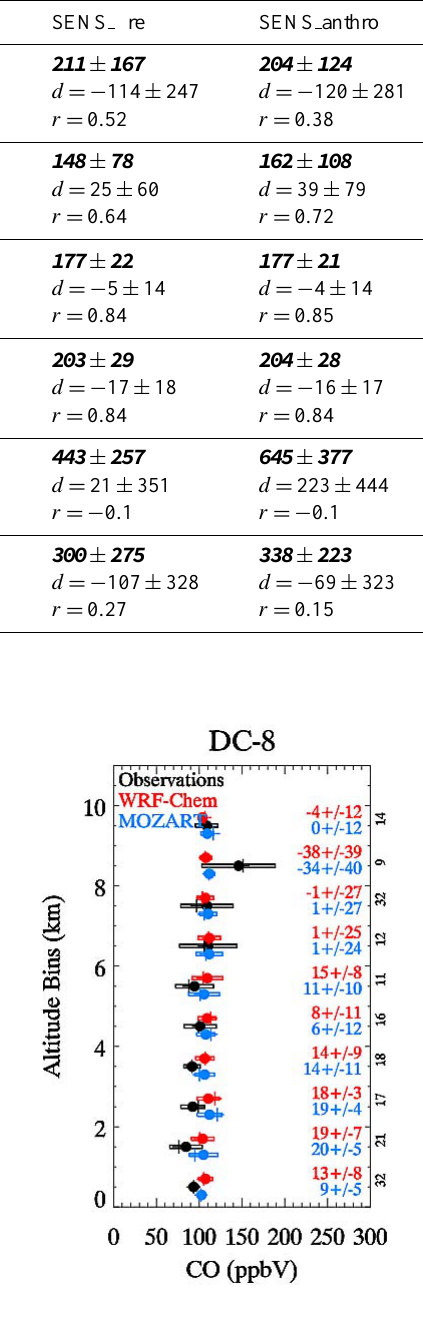
Fig. 2. Mean (circles), median (plus signs) and standard devia- tion (bars) of observed (black), WRF-Chem (red) and MOZART-4 (blue) CO profiles for the 22 June 2008 DC-8 Boundary Conditions Flight (ocean segment only). Mean difference and standard devia- tion between model and observations is specified. The number of data points per altitude bin is specified next the vertical